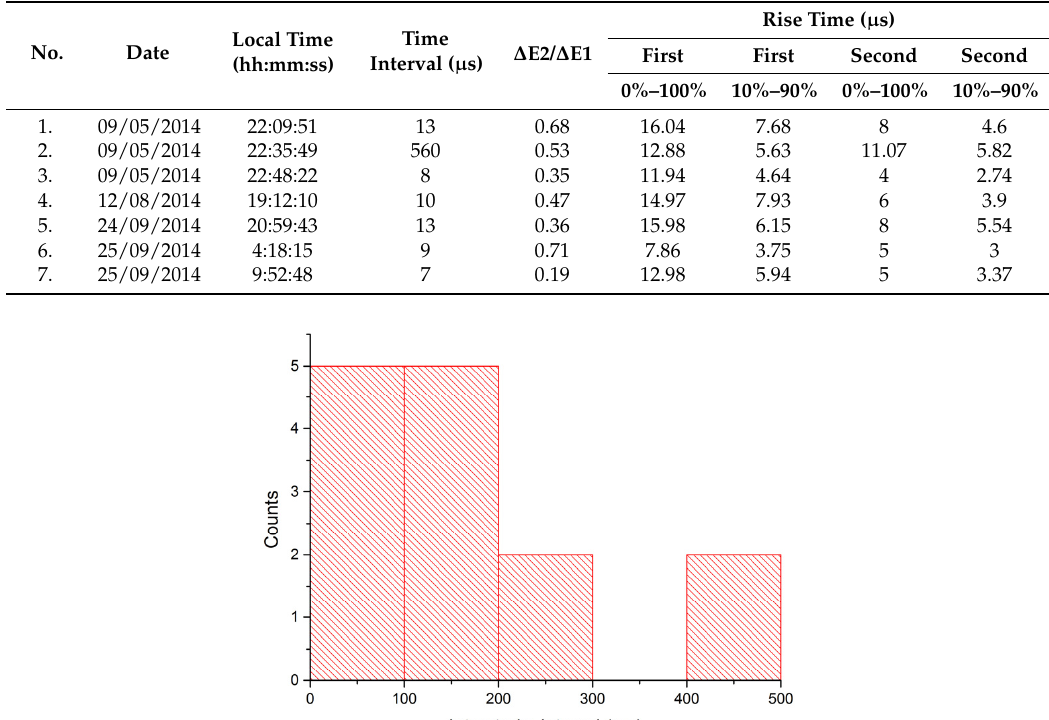
Figure 4. Typical double electric field waveform ( a , b ); expanded positive CG electric field waveform with very short time interval ( c , d ). Table 3. Summary of very short interstroke interval characteristics.